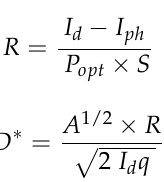
Table 2. Performance summary of the perovskite and C-dot/perovskite photodetectors.